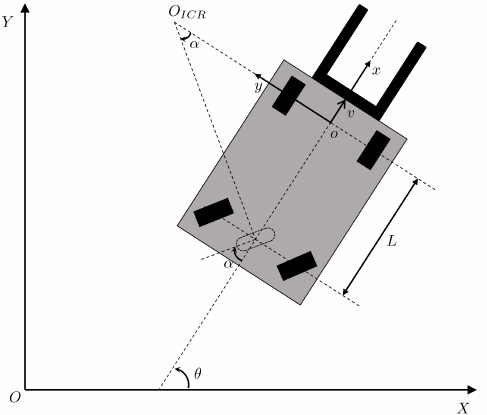
Figure 3. Schema of the forklift with a spin-turn steering